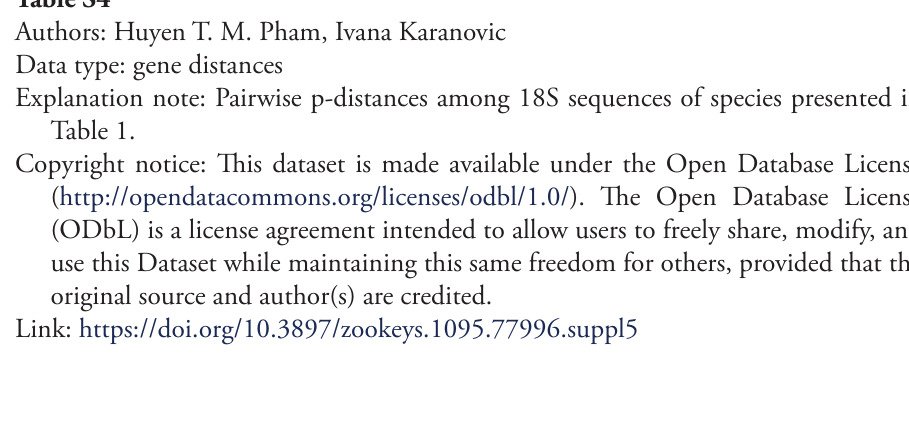
Authors: Huyen T. M. Pham, Ivana Karanovic Data type: gene